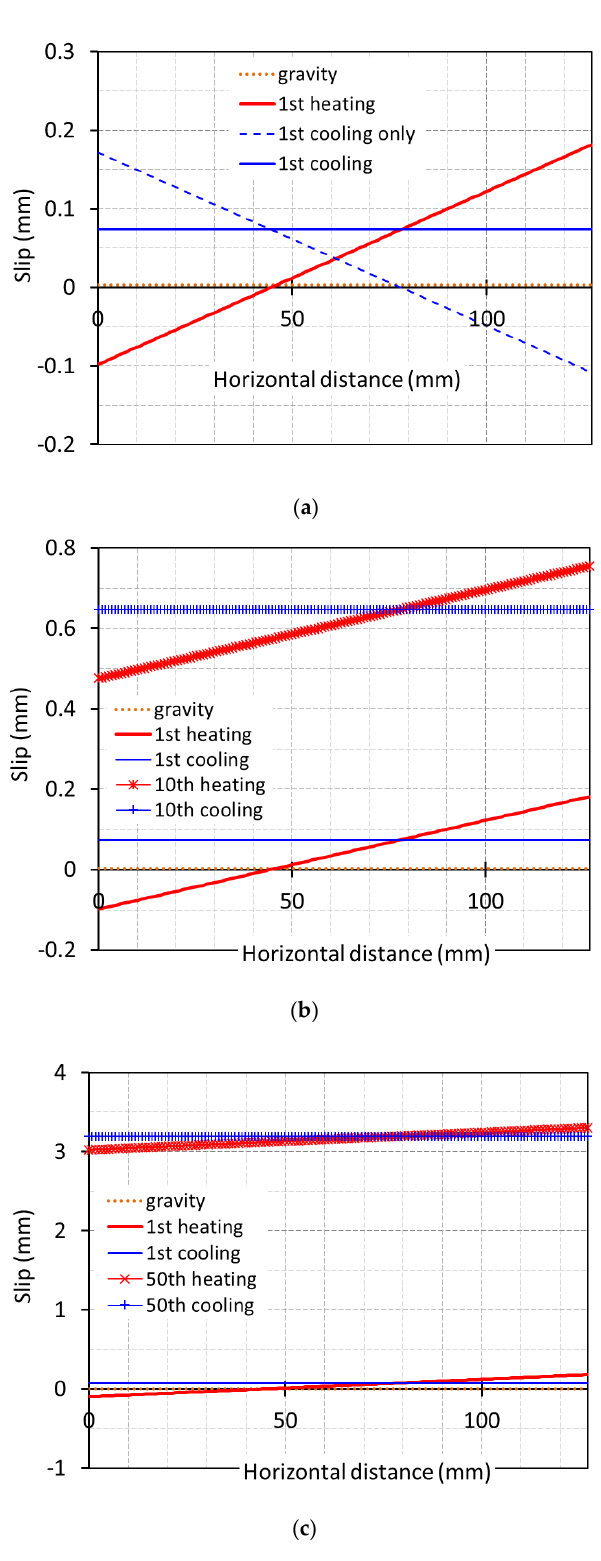
Figure 11. Distributions of the interface slip. The presented results are based on ∆𝑇 = 23 ℃ in 𝛽 = 5° slope with the parameters in Table 1. ( a ) gravity only (dotted line), after 1st heating (red solid line), during 1st cooling (blue dashed line), and after 1st cooling (blue solid line), ( b ) after 10th heating (red solid line with cross) and cooling (blue solid line with tick) in addition to ( a ), and ( c ) after 50th heating (red solid line with cross) and cooling (blue solid line with tick) in addition to ( a ).